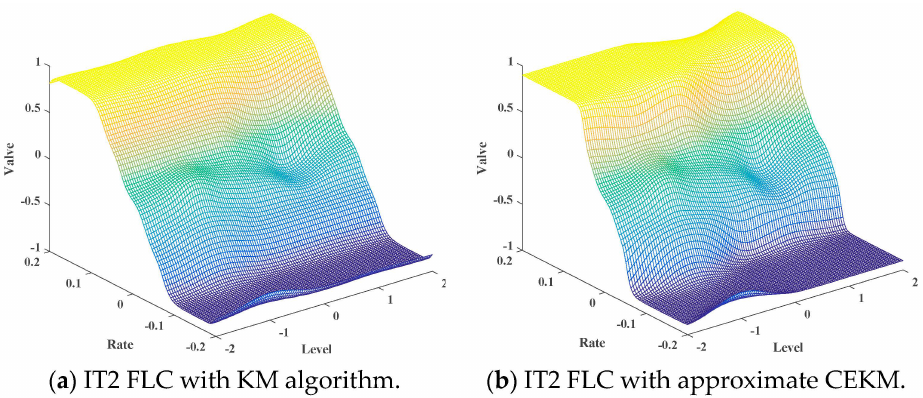
Figure 6. IT2 FLC control surfaces.